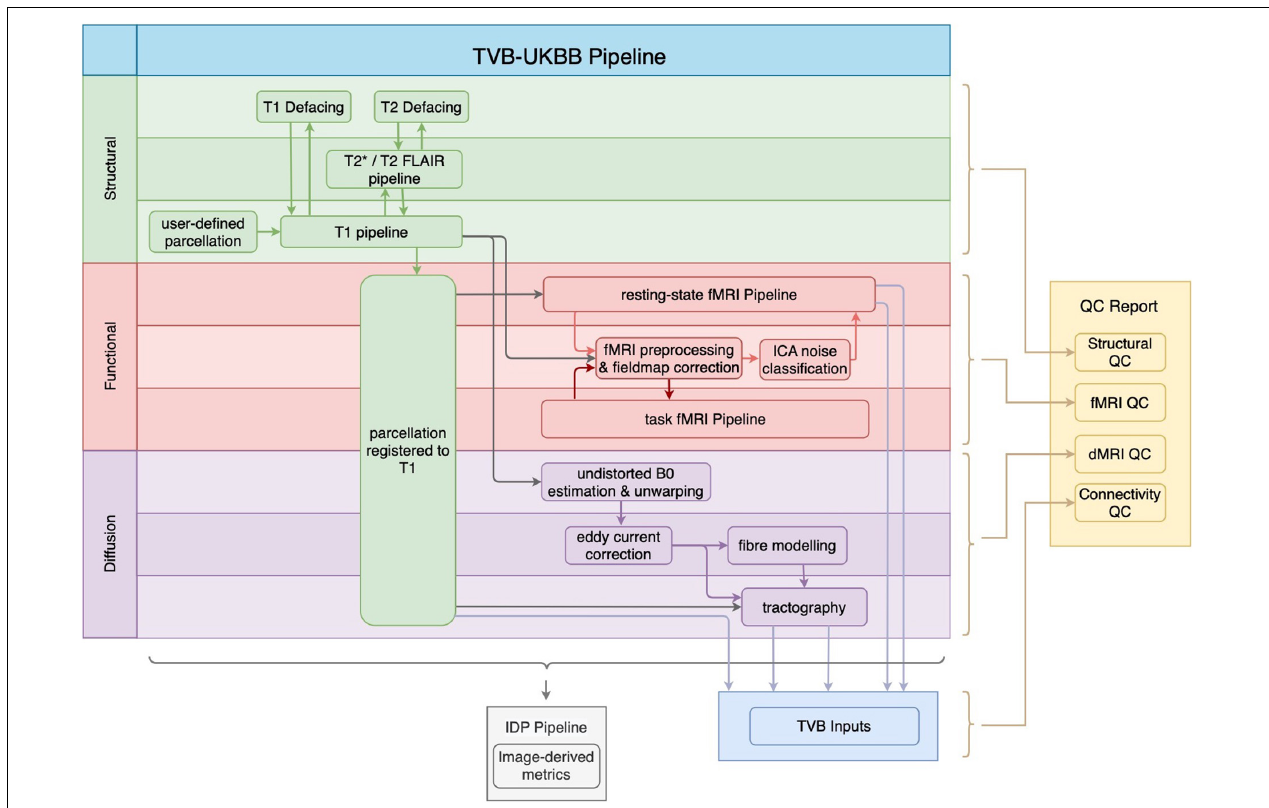
FIGURE 1 | General workflow of the TVB-UKBB pipeline. The main imaging sub-pipelines of interest for the current paper are shown (structural in green, functional in red, and diffusion in purple). A TVB-compatible .zip file (TVB Inputs) is created from the relevant outputs of the imaging sub-pipelines. The “IDP Pipeline” collects image-based metrics from raw, intermediate and processed outputs across imaging sub-pipelines and makes them available for analysis. The final step of the pipeline is the generation of the QC